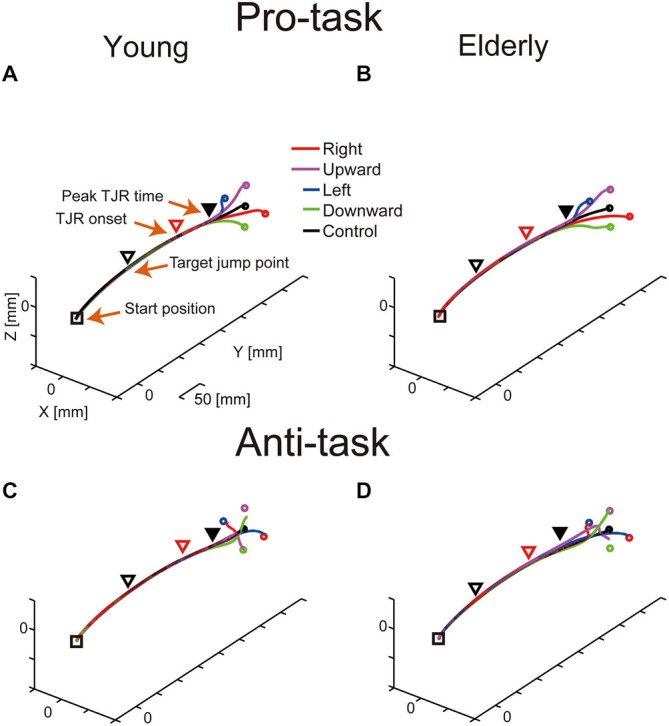
Typical examples of mean reaching trajectories during the pro-task (A,B) and anti-task (C,D) performed by young (A,C) and elderly (B,D) participants. Squares and triangles indicate the starting hand position and the mean hand position at the moment of target displacement, respectively. Red triangles indicate TJR onset, and filled, black triangles indicate peak TJR time. Circles represent endpoints in the pro-task for each target displacement direction.